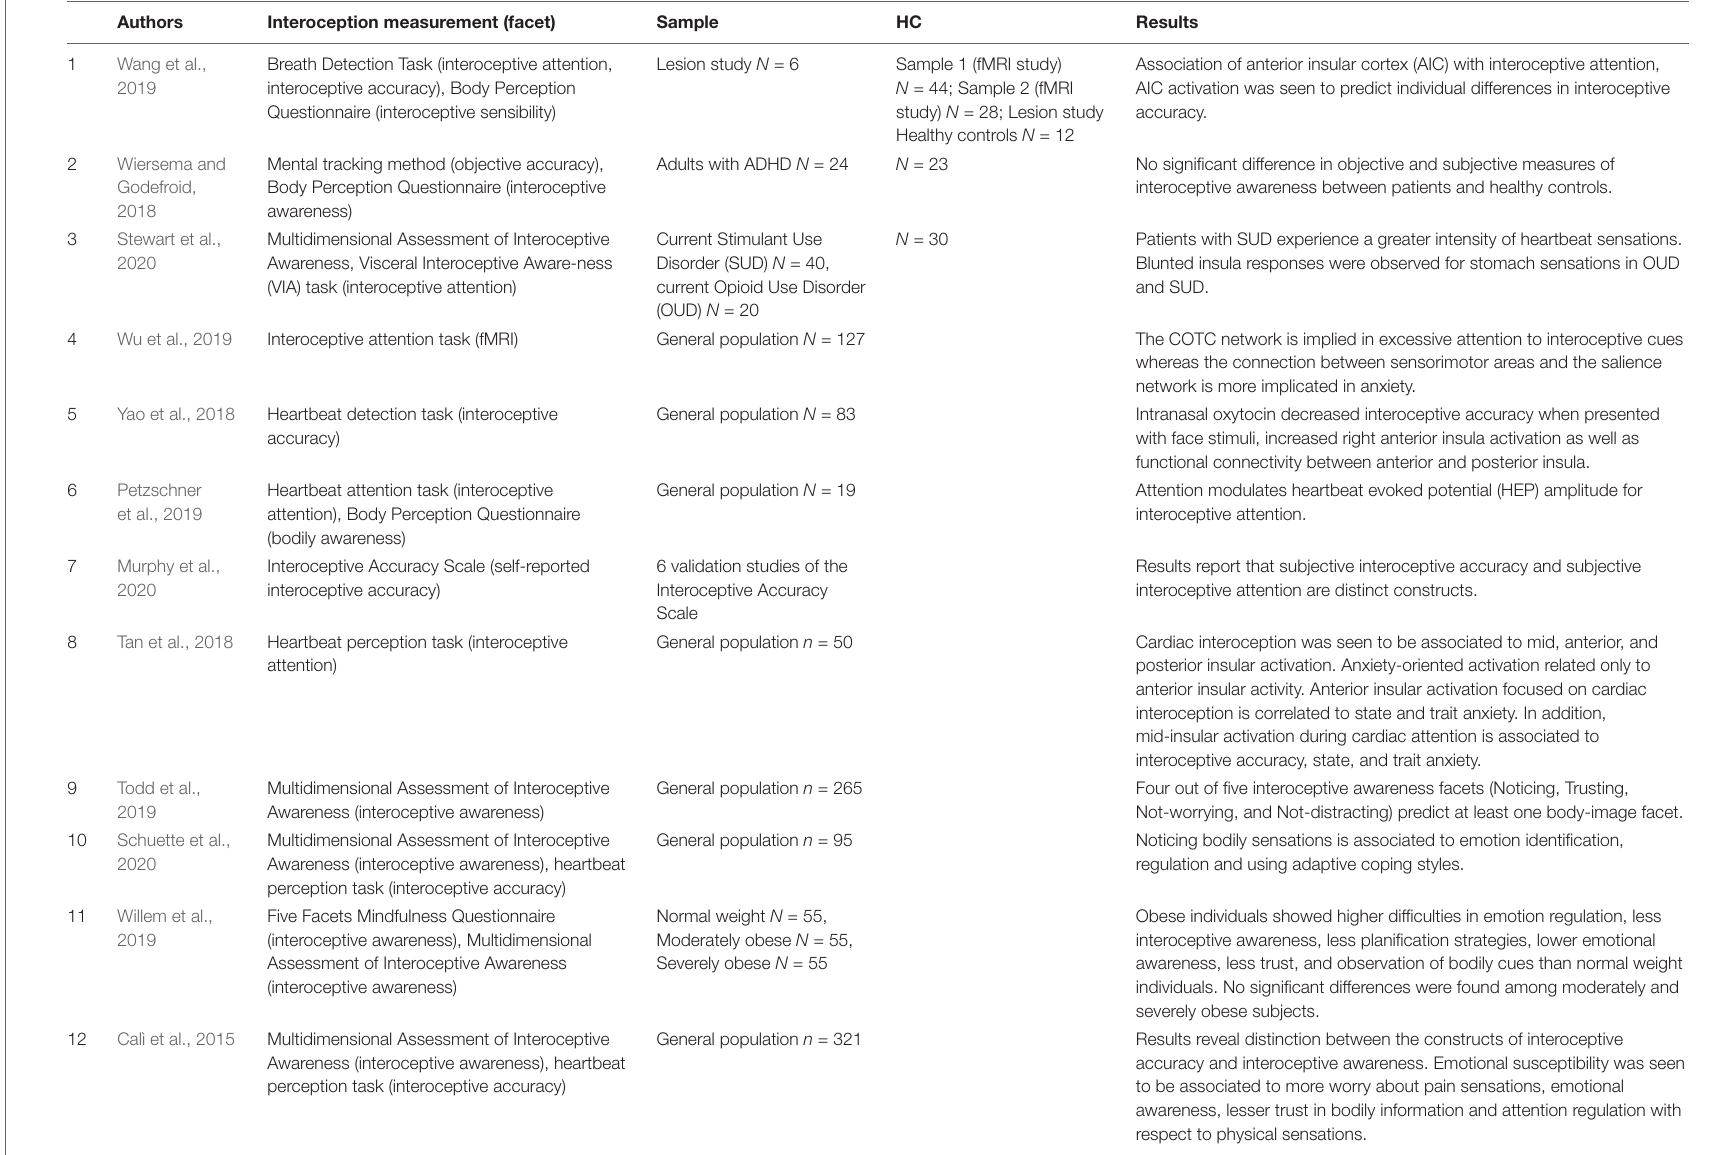
TABLE 1 | Studies assessing interceptive attention, appraisal, and interoceptive regulation. Authors